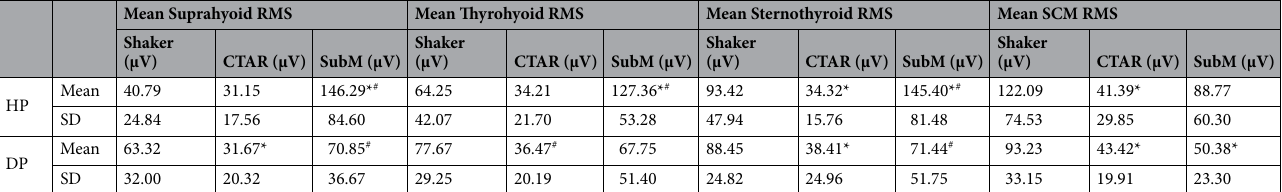
Table 3. The mean RMS value of the suprahyoid, thyrohyoid, sternohyoid, and SCM muscles in healthy participants and patients with dysphagia. RMS, root mean square; SD, standard deviation; CTAR, chin tuck against resistance; SubM, submandibular push exercise; SCM, sternocleidomastoid; Max, maximum; HP, healthy participants; DP, dysphagic patients. vs. Shaker, * p < 0.05; vs. CTAR, # p < 0.05.